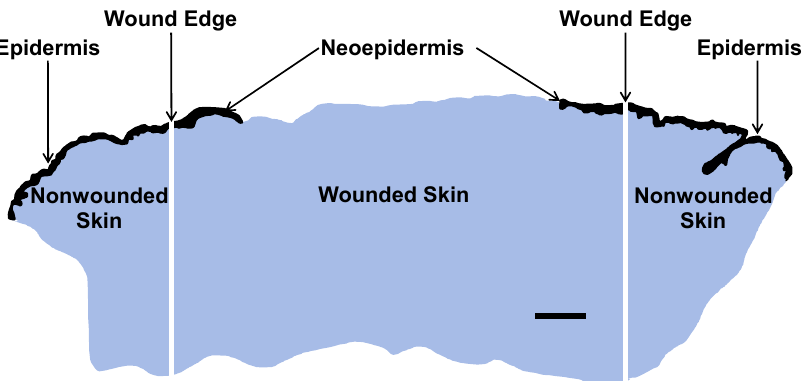
Figure 6. Macrodissection of FFPE tissue section of a day-4 suction blister wound into central wound (1 piece) including neoepidermis and adjoining nonwounded normal skin including epidermis (2 pieces). Reepithelialization was calculated using the following formula: Neoepidermis (mm)/Wound length (mm) × 100%. Total RNA was extracted, and the extracts were subjected to nCounter mRNA analysis. Epidermal compartments are black and dermal compartments blue. Scale bar, 1